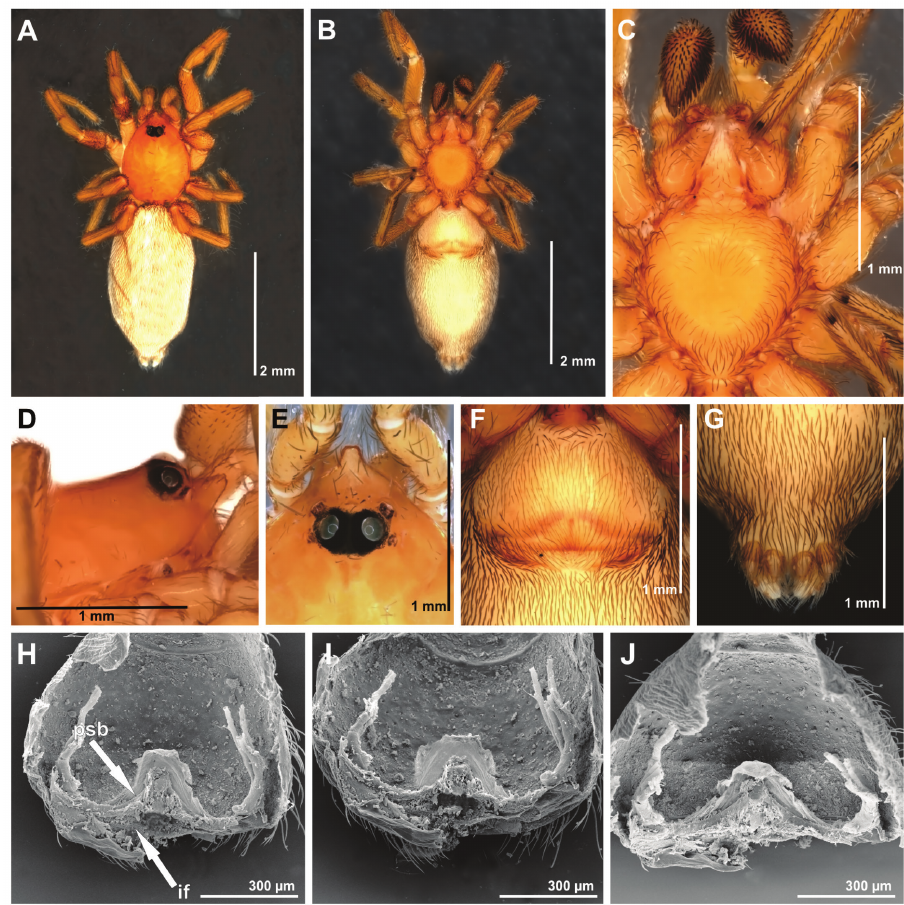
Figure 12. Nasutonops sincora sp. n., female from Contendas do Sincorá, Bahia ( A–G ). A habitus, dorsal view B same, ventral view C carapace, ventral view D ocular area, lateral view E same, dorsal view F genital area, ventral view G spinnerets, ventral view. Nasutonops xaxado sp. n. ( H–J ) H SEM images of internal genitalia, dorsal view I same, posterior view J same, anterior view (if = internal transversal fold; psb = pair of sclerotized bars). Scale bars: A–G 0.5